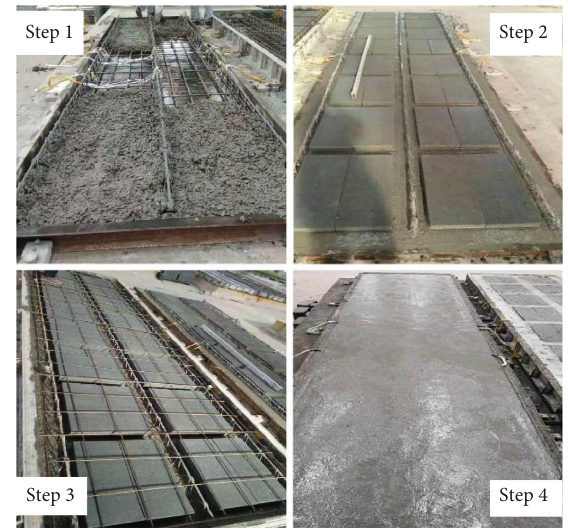
Figure 4: Stages of construction.